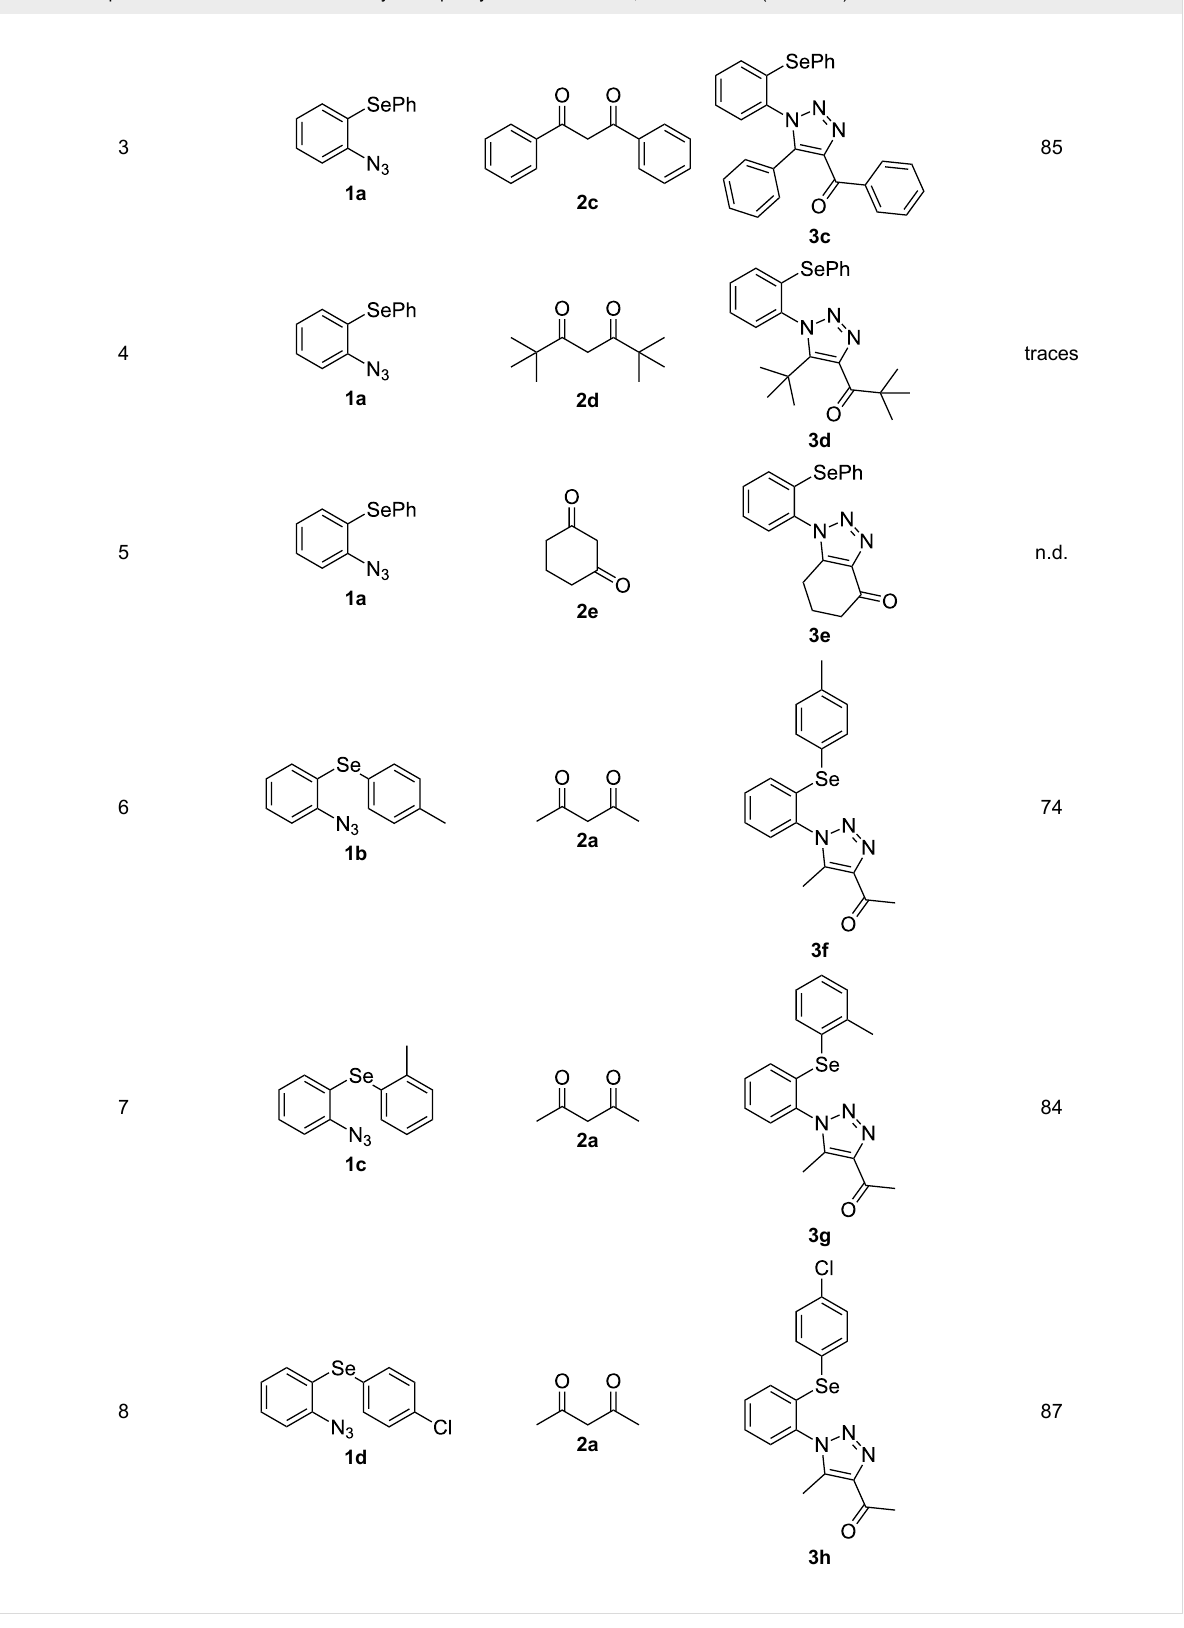
Table 2: Scope of substrates: Variation of the aryl azidophenyl selenides 1 and 1,3-diketones 2 . a